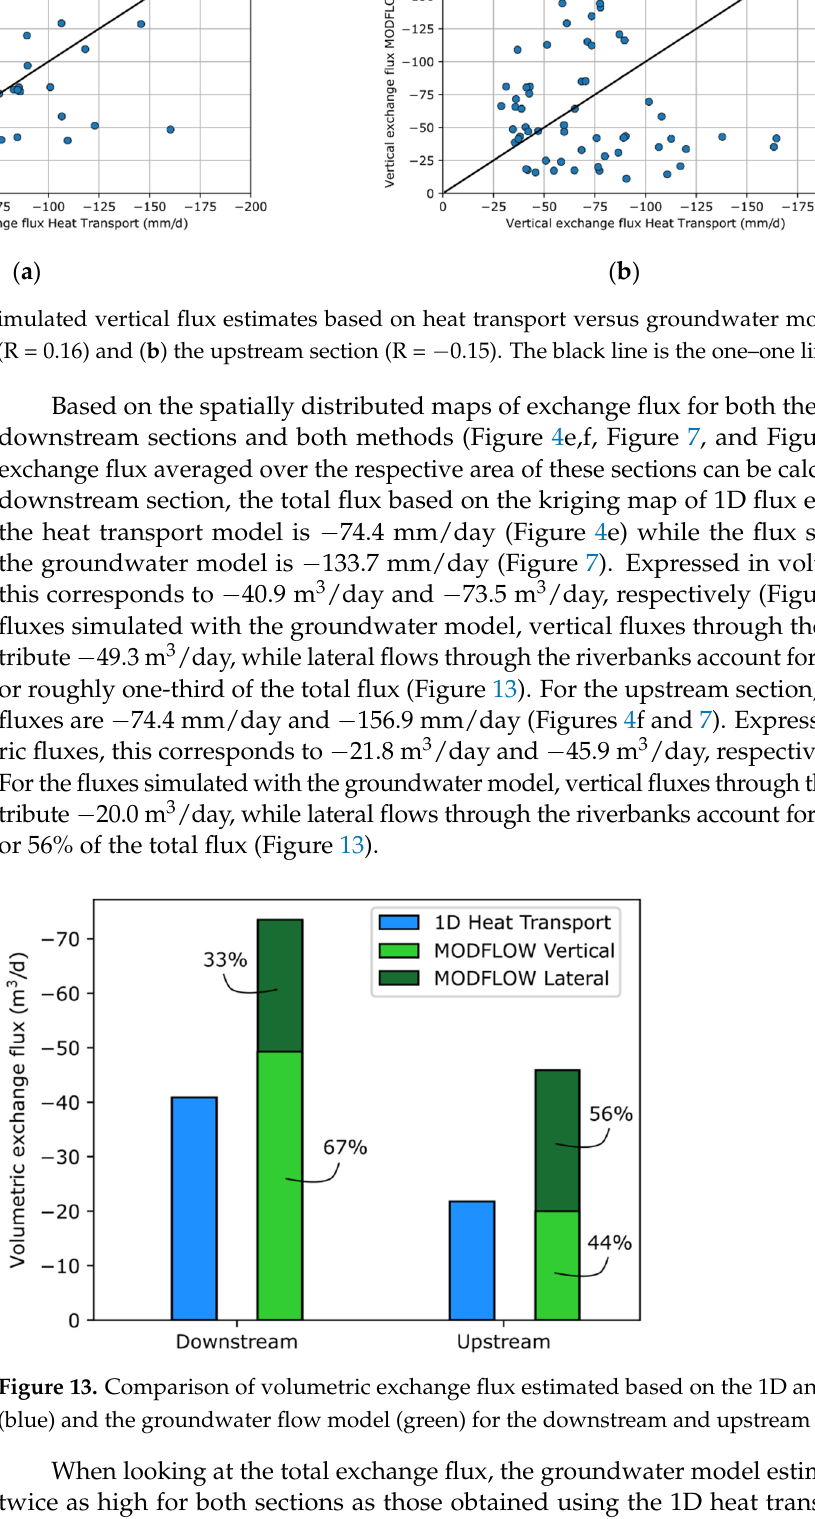
Figure 11. Boxplots of vertical fluxes simulated with heat transport modelling (blue) and groundwater modelling (green) for both the downstream and upstream sections.